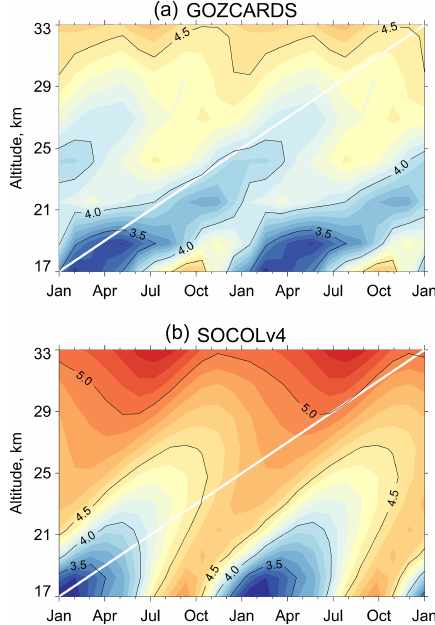
Figure 10. Annual cycle of water vapor mixing ratio (ppmv) aver- aged between 15 ◦ N and 15 ◦ S and over 1991–2012 for the GOZ- CARDS satellite composite (a) and SOCOLv4 (b) . Two consecu- tive cycles are shown. The white line in both panels indicates the approximate slope of the GOZCARDS tape recorder